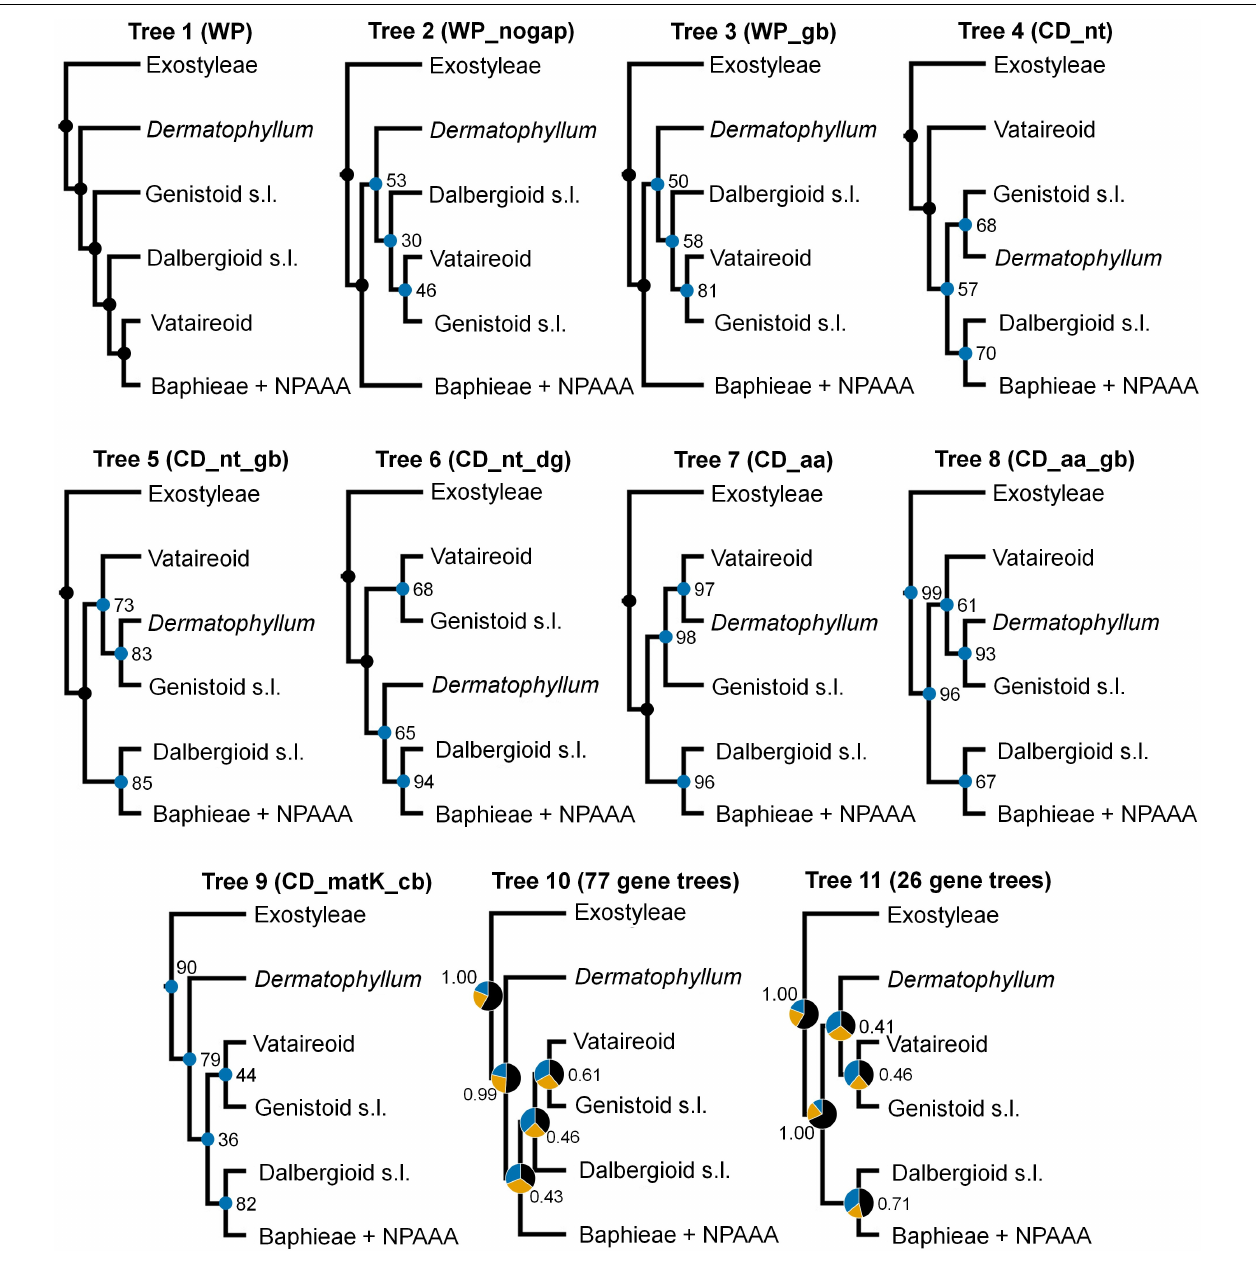
FIGURE 4 | Differences in topology and support values for the 11 trees with respect to resolving the phylogenetic relationships among the Vataireoid, Dermatophyllum , Genistoid s.l., Dalbergioid s.l., and Baphieae + NPAAA (non-proteinogenic amino acid accumulating) clades. Nodes with maximal bootstrap support (100) are denoted as black dots, while other nodes are marked with blue dots with values in nine trees (Trees 1–9). In Trees 10 and 11, based on the multispecies coalescence approach, pie charts representing quartet score values of topologies (black = main, orange = first alternative, blue = second alternative) and local posterior probability are presented at